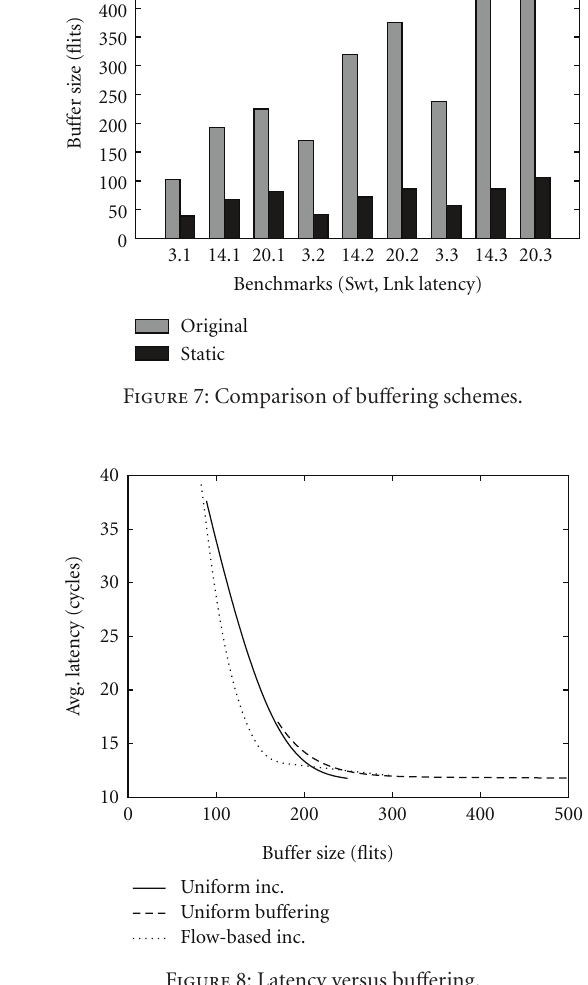
Figure 8: Latency versus bu ff